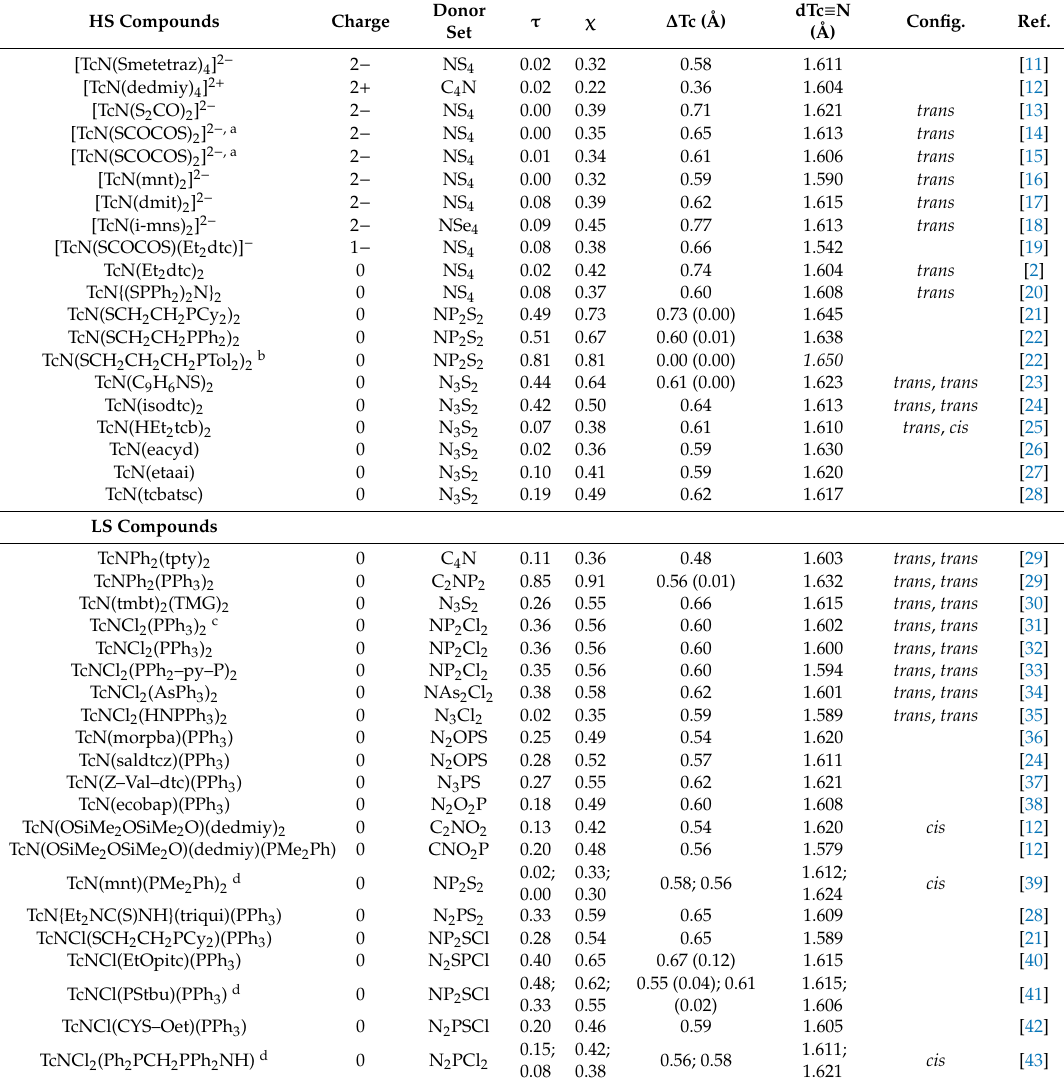
Table 1. Structural parameters of higher symmetry (HS) five-coordinated Tc(V) nitride complexes and of lower symmetry (LS) five-coordinated Tc(V) nitride